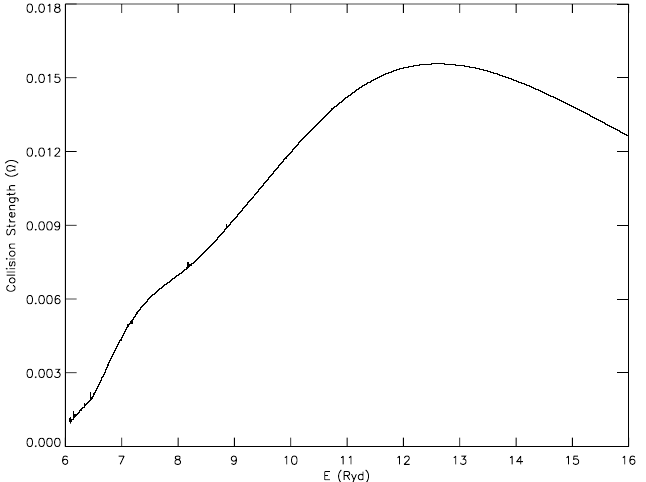
Figure 4. Collision strengths for the 30–232 (2s4s 1 S 0 –2p7d 3 D o calculations of [26].